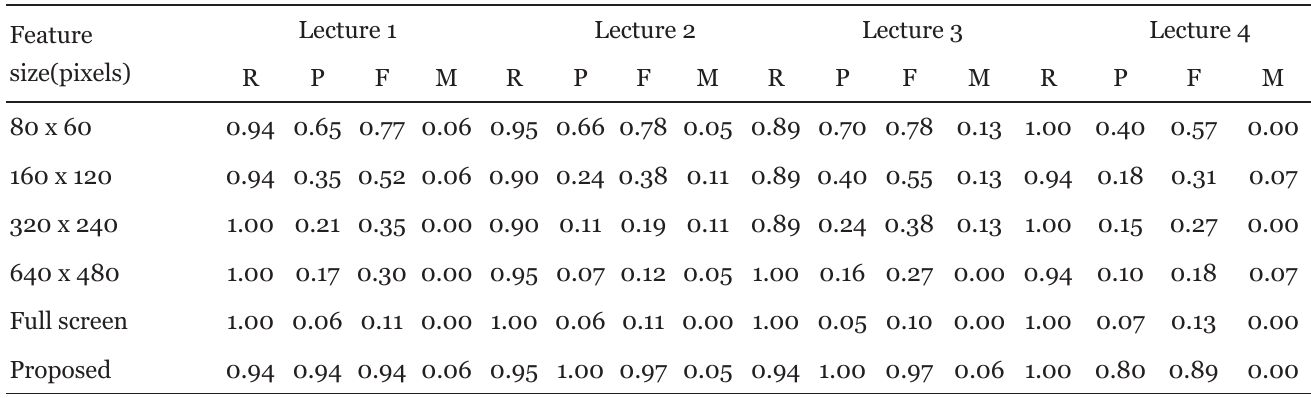
Feature Region Results for